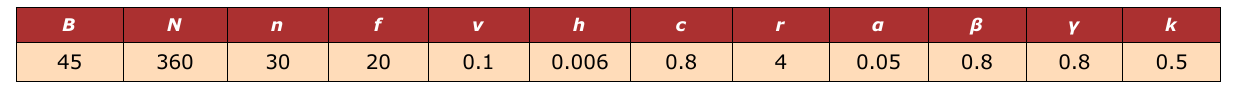
Table 2. Parameter